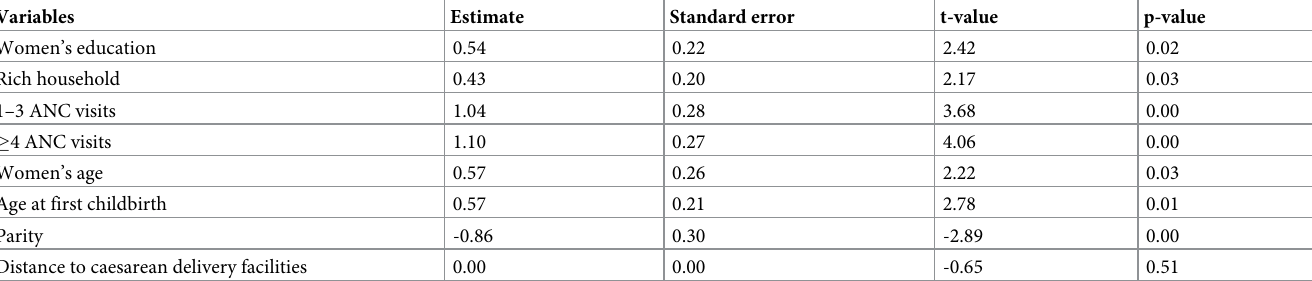
Table 3. Factors associated with the spatial variations of caesarean delivery use in Ethiopia, 2016.